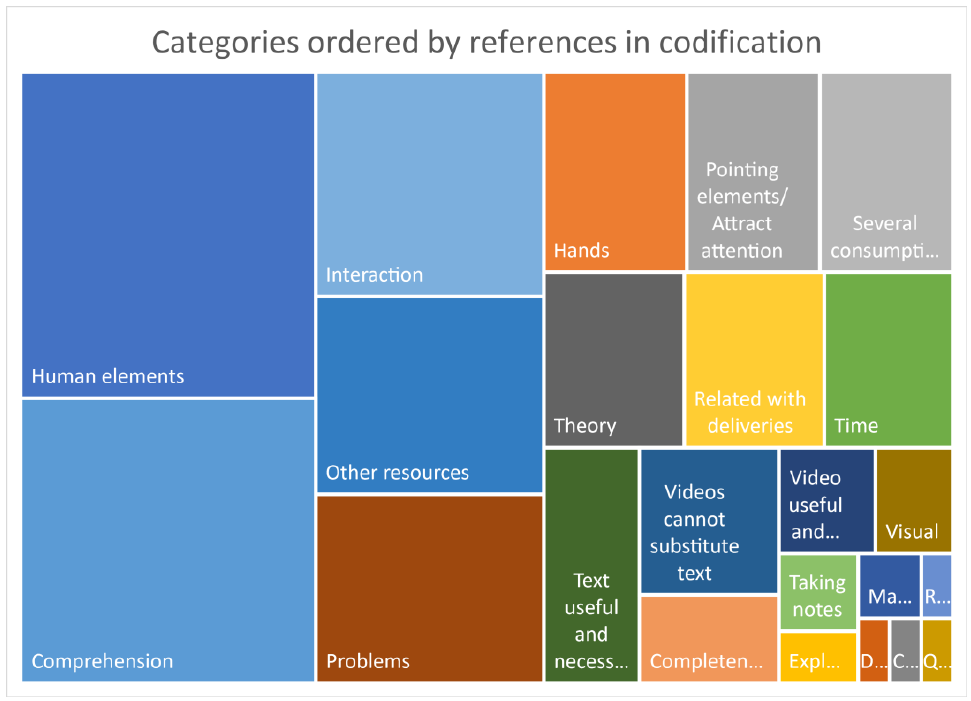
Figure 10. Mapping tree of the relative importance of every category.